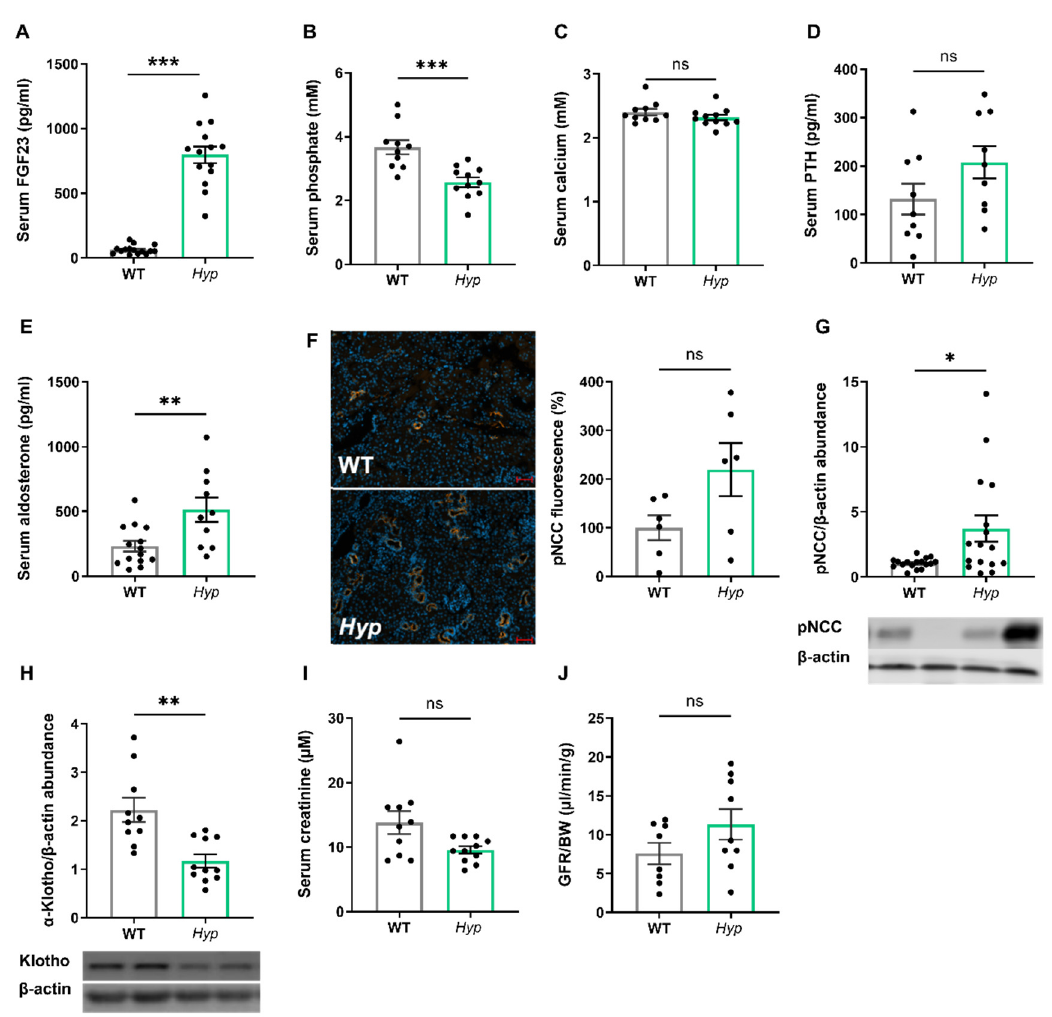
Figure 1. Aged Hyp mice show a stimulation of the RAAS and a down-regulation of renal α Klotho protein abundance, but have normal kidney function. ( A ) Serum intact FGF23 levels (n = 14–15), ( B , C ) serum phosphate and calcium concentrations (n = 10–11), and ( D , E ) serum intact PTH and aldosterone levels (n = 9–14) in 14-month-old male wildtype (WT) and Hyp mice. ( F ) Left: representative images of immunofluorescent staining of kidney paraffin sections with an anti-pNCC antibody (original magnification 400×). Right: quantification of anti-pNCC immunofluorescence in the kidney in 14-month-old male WT and Hyp mice (n = 6). Western blot quantification of ( G ) pNCC and ( H ) α -Klotho from kidney cortex homogenates (n = 6–11), as well as ( I ) serum creatinine levels (n = 10–11) and ( J ) glomerular filtration rate per gram body weight as measured by renal creatinine clearance (n = 8–9) in 14-month-old male Hyp mice and WT controls. Bars in ( A – J ) represent mean ± SEM for WT and Hyp mice. * p < 0.05, ** p < 0.01, *** p < 0.001 by Student’s t -test. ns, not significant. 3.1. Elevated Levels of Circulating FGF23 Are Associated with Mild Hypertension in Aged Hyp Mice but Do Not Cause LVH Several earlier reports have failed to find LV hypertrophy in Hyp mice of up to nine months of age [17,18]. However, data about potential changes in cardiovascular function in aged Hyp mice as a model of long term FGF23 excess are scarce. Therefore, we examined the cardiovascular phenotype of aged Hyp mice by intraarterial and left ventricular cath- eterization as well as by echocardiography. The HW/BW ratio was distinctly increased in Hyp mice relative to WT controls (Figure 2A). However, this increase was mainly driven